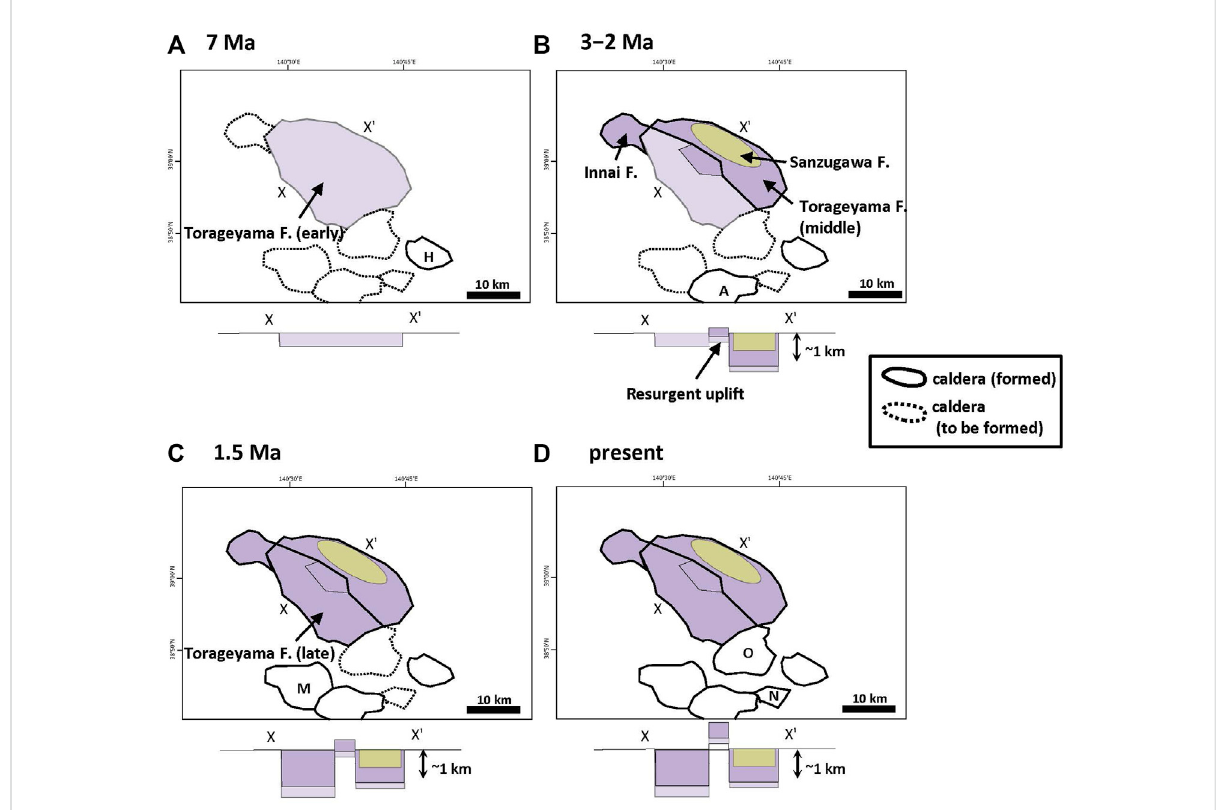
FIGURE 8 Schematics showing evolution of the Sanzugawa and nearby calderas. (A) 7 Ma, (B) 3 – 2 Ma, (C) 1.5 Ma, (D) present. Note that the evidence of ~7 Macalderaisweak.Caldera- fi llpyroclasticsedimentsintheSanzugawaandInnaicalderasareshowninpurple. Lakesedimentsareinyellow.X,X ′ show vertical cross-section positions. Abbreviations for calderas are H: Hanayama, A: Akakura, M: Mukaimachi, O: Onikobe, N: